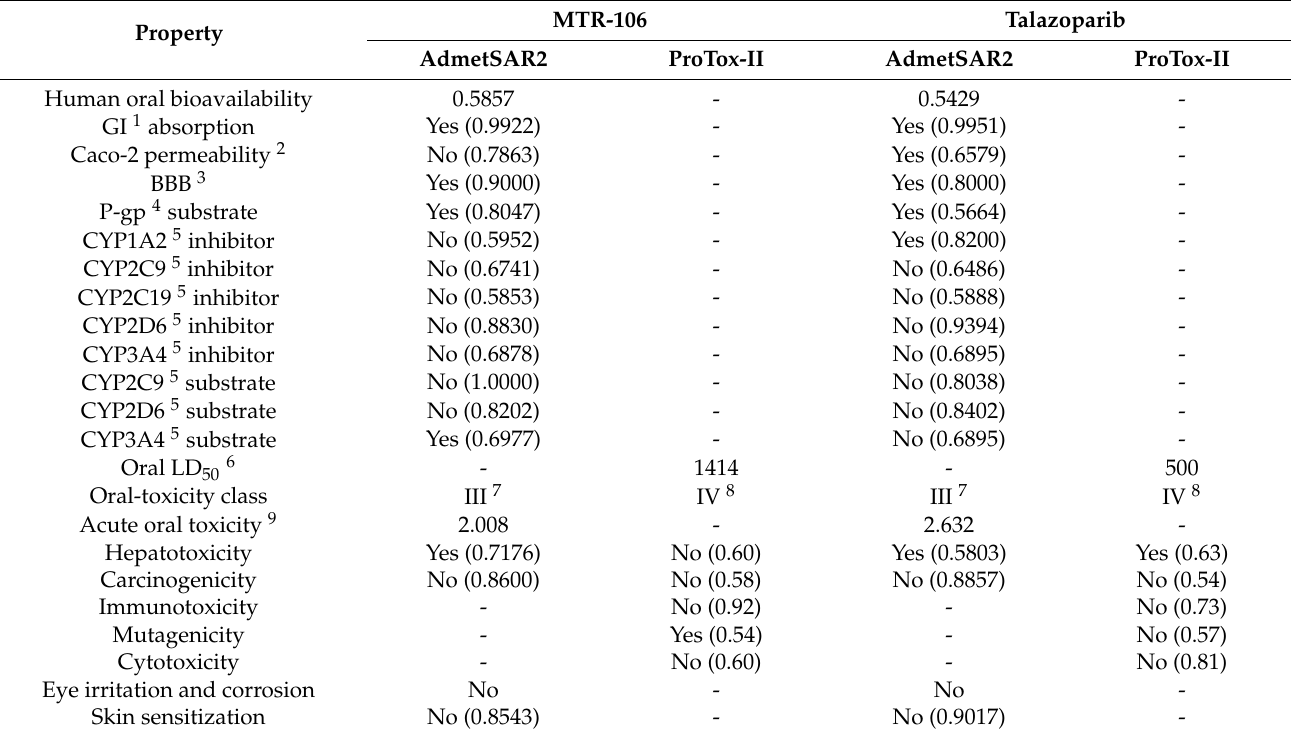
Table 5. The ADMET properties of MTR-106 and